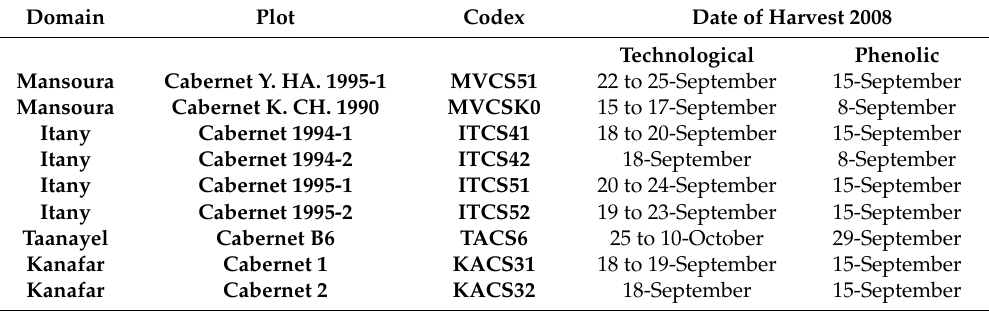
Table 2. Technological harvest date and phenolic peak for each plot of Cabernet Sauvignon for the 2008